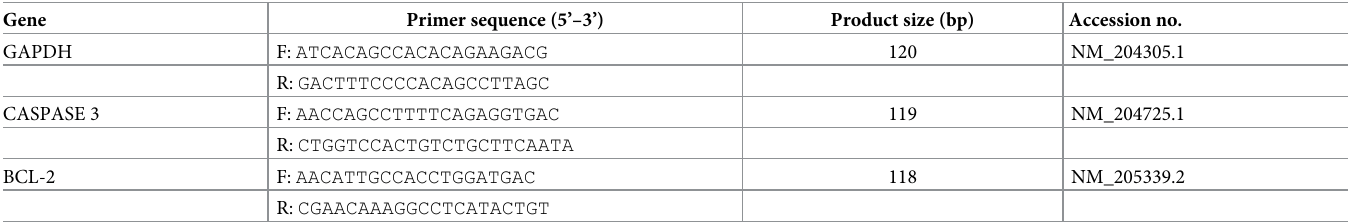
Table 2. Primer sequences used for quantitative real-time polymerase chain reaction. Gene Primer sequence (5’–3’) Product size (bp) Accession